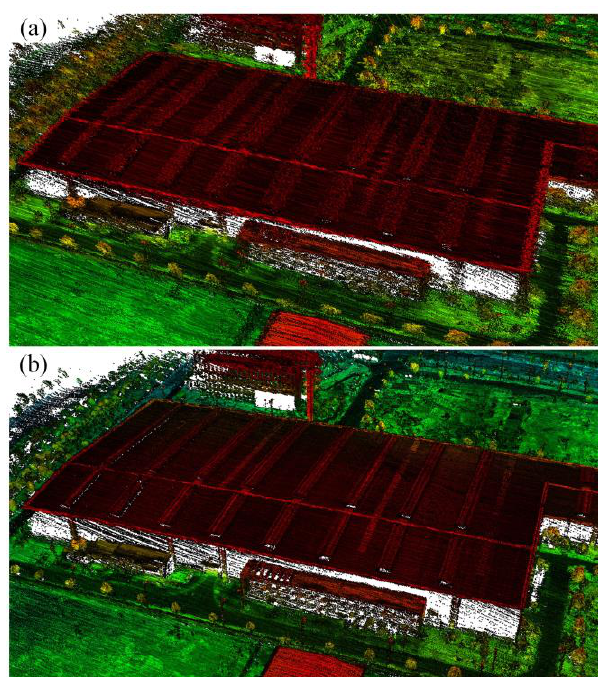
Fig.9 LiDAR point clouds geo-referenced using different strategies. (a) Direct geo-referencing using calibrated boresight parameters and trajectory from low-end GNSS/IMU integration. (b) Direct geo-referencing using calibrated boresight parameters and trajectory from the